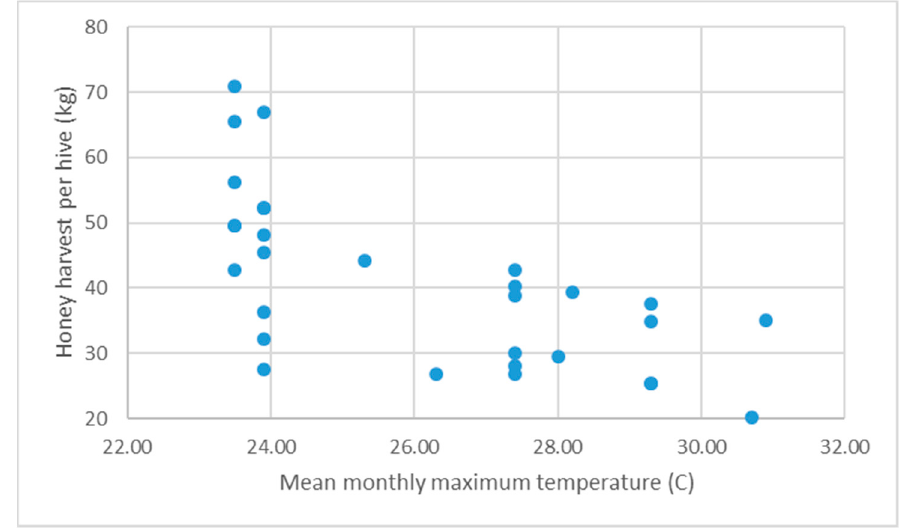
Figure 7. Mean monthly maximum temperature for November (MaT3) versus honey harvest weight.